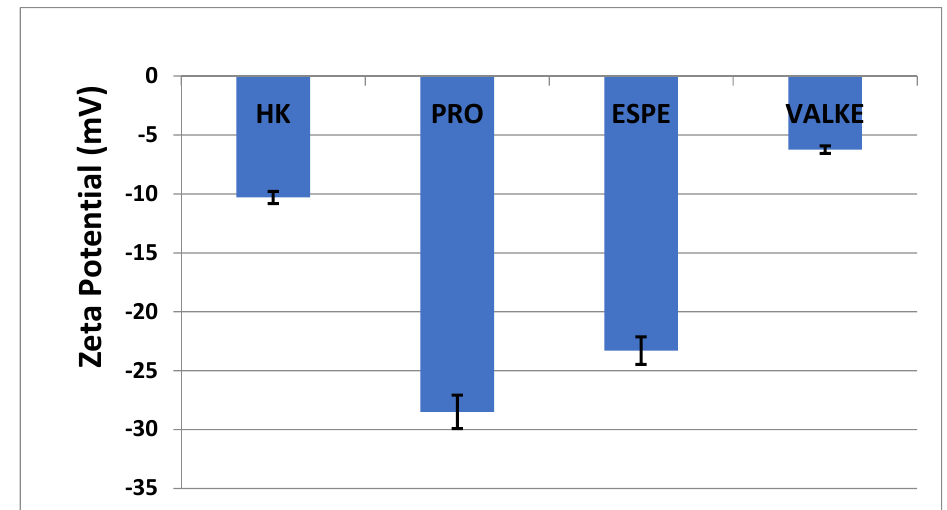
Figure 3. Zeta potential of keratin hydrolysates.